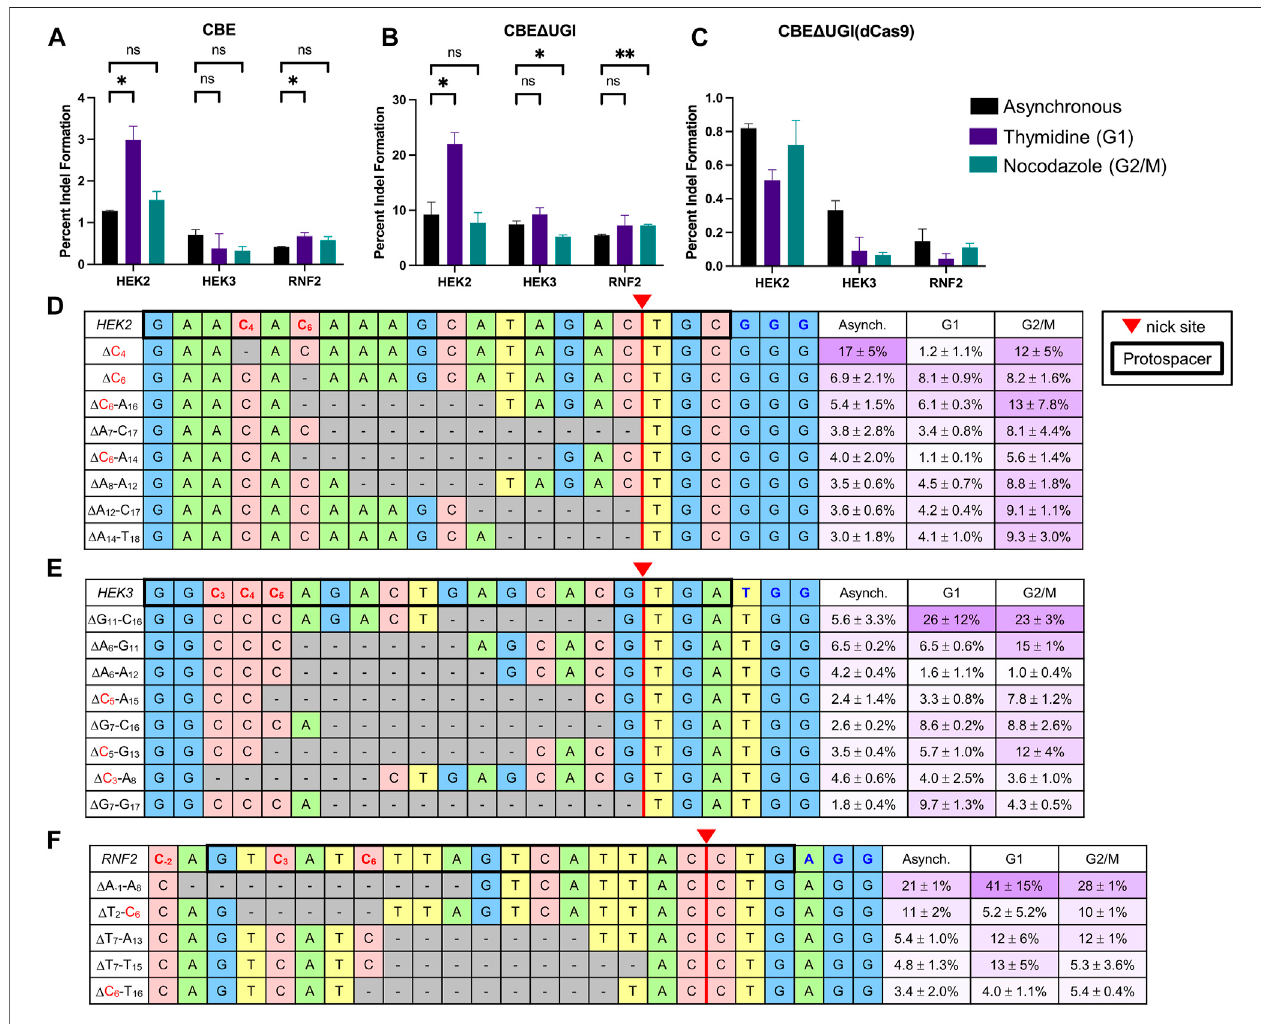
FIGURE 4 | Indel analysis of CBEs in HEK293T cells. HEK293T cells were transfected with CBE (A) , CBE Δ UGI (B) , or CBE Δ UGI (dCas9) (C) plus gRNA (protospacer sequences indicated in Figure 1 ), synchronization agents were added 6 h post-transfection (thymidine for G1 synchronization or nocodazole for G2/M synchronization), and cells were lysed at 54 h. The genomic DNA was extracted and target loci were ampli fi ed via PCR and subjected to HTS. Total indel introduction ef fi cienciesforCBE (A) ,CBE Δ UGI (B) ,andCBE Δ UGI(dCas9) (C) werecalculatedasthepercentofreadswithinsertionsordeletions(determined via CRISPResso analysis) divided by the total number of HTS reads sequenced. (A – C) Effects of synchronization in G1 or G2/M on indel introduction ef fi ciencies. (D – F) The most common (de fi ned as sequences that comprise greater than 0.1% of total reads in at least two out of three of the asynchronous, G1-synchronized, and G2/ M-synchronized samples) indel sequences are shown with respect to the protospacer (bold outline), potential edited cytosines (indicated in red), nick site (red triangle), andPAM(indicatedinblue)forthe HEK2 (C) , HEK3 (D) ,and RNF2 (E) sites.Therelativeportionoftotalindelreadswitheachspeci fi cindelsequenceislistedontheleftin purple with respect to synchronization condition (note these are not absolute indel introduction ef fi ciencies). Values and error bars re fl ect the means and SD of three independent biological replicates performed on different days. Asterisks re fl ect p value calculations of unpaired t test, one tailed (ns indicates not signi fi cant, * p < 0.05, ** p < 0.01, *** p <